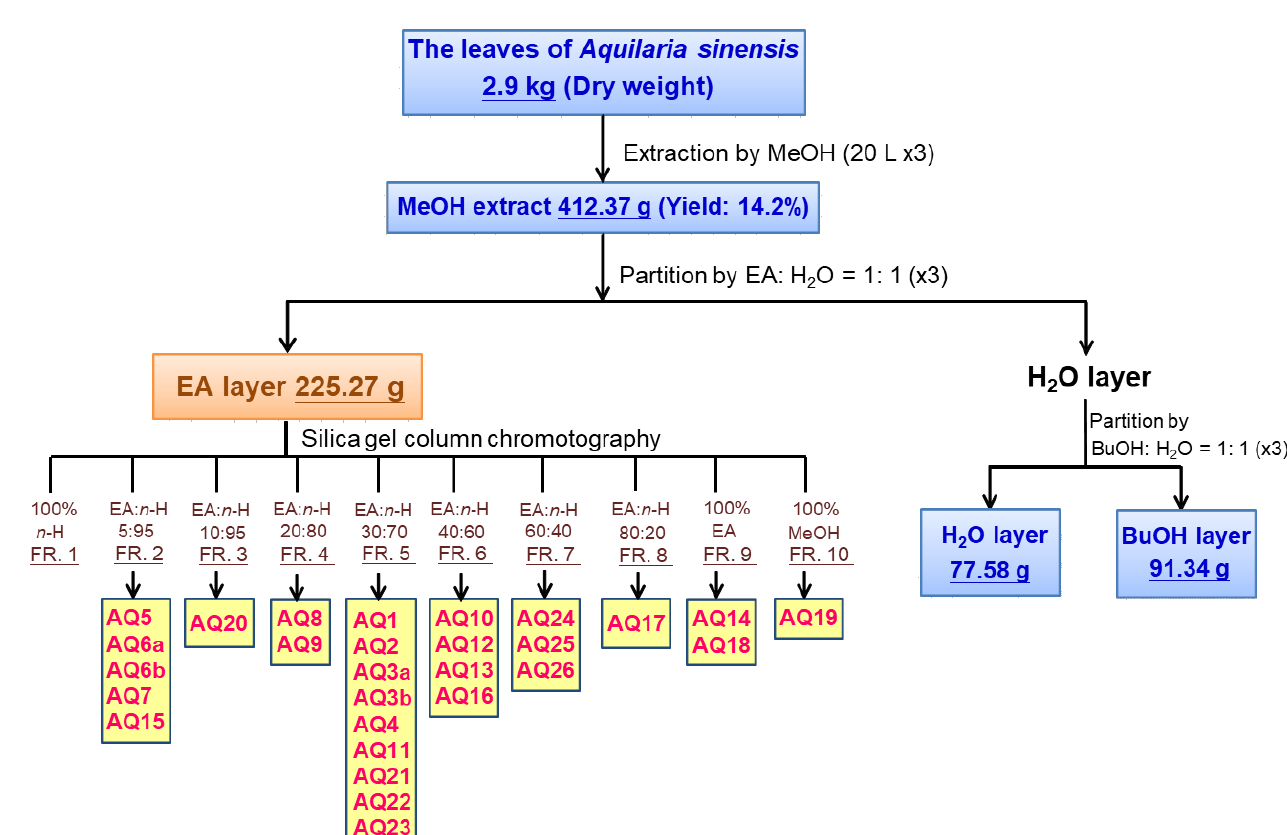
Figure 2. Flow diagram of bioassay-guided procedure. Bioassay-guided fractionation and isolation of the MeOH extract of the leaves of A. sinensis resulted in the isolation of 28 compounds.